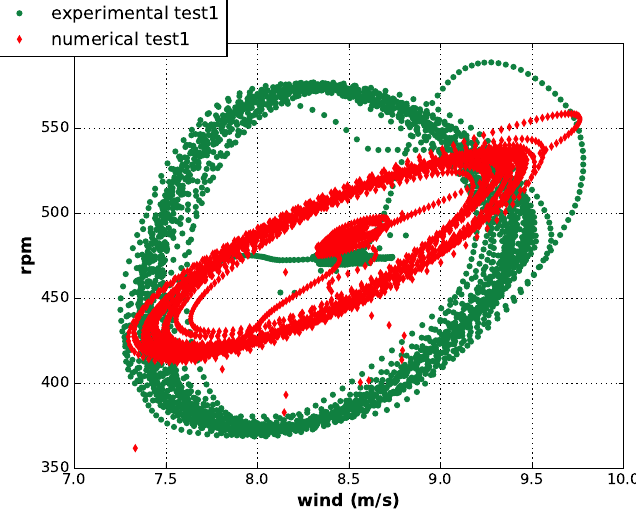
Figure 8. Power versus rotor speed for experimental measurements of test 1 (green) and test 3 (black) compared to the numerical results (red).